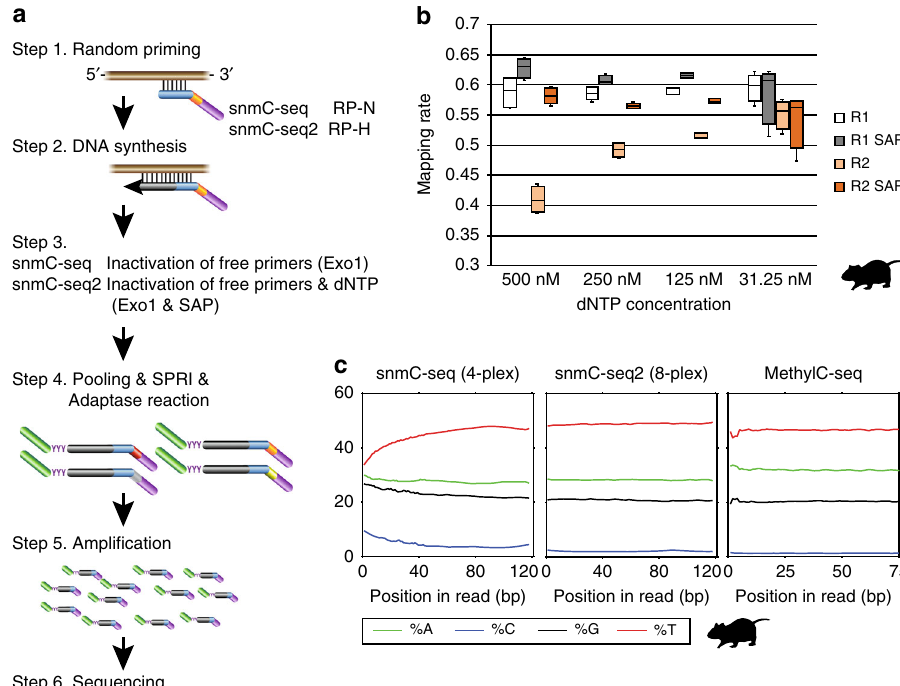
Fig. 1 Improvement of single-cell methylome read mapping. a Schematics of snmC-seq work fl ow. Steps modi fi ed in snmC-seq2 are highlighted. RP-N and RP-H indicate random primers used in snmC-seq and snmC-seq2, respectively. Exo1 exonuclease 1, SAP shrimp alkaline phosphatase, SPRI solid-phase reversible immobilization. b Reverse read (R2) mapping is improved by reducing nucleotide concentration in random-primed DNA synthesis reaction or treatment with shrimp alkaline phosphatase, whereas forward read (R1) mapping is not affected. Each condition contained four biological replicates. c snmC-seq2 produces reverse reads with comparable base composition as MethylC-seq reads. The elements of all box-plots are de fi ned as following — center line, median; box limits, fi rst and third quartiles; whiskers, 1.5× interquartile